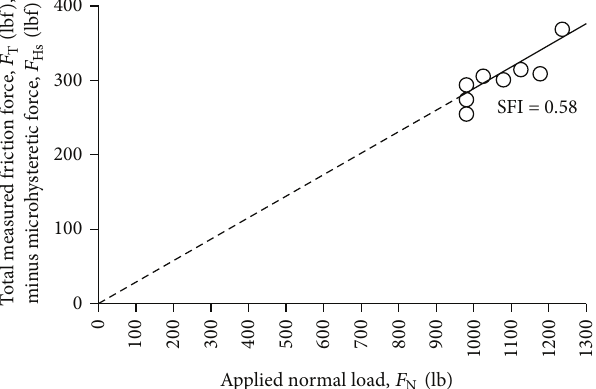
Figure 21: Wet Tyrone Boulevard test results showing the sliding friction index (SFI)